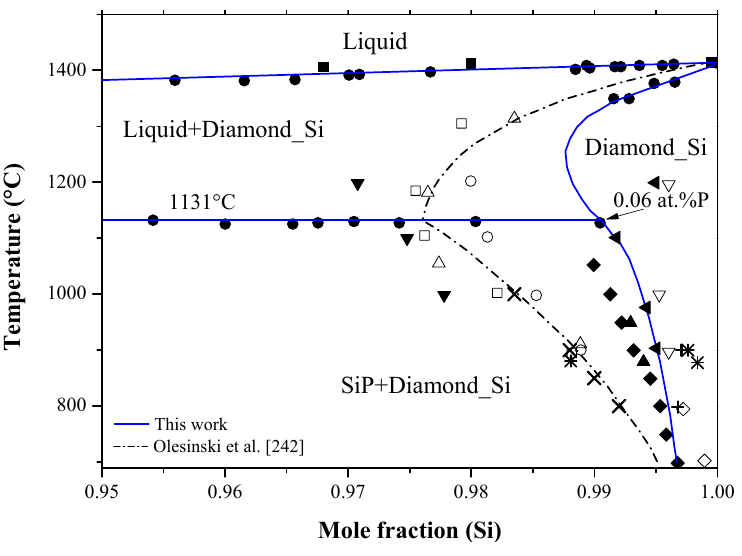
Figure 28. Assessed Si-terminal solid solution in relation to the available data; -·-·-·-: [242]; □ : [118]; ■ : [241]; Δ : [243]; : [244]; : [245]; × : [246]; +: [247]; ▲ : [248]; *: [250]; ▼ : [252]; ○ : [249]; ♦ : [253]; ◄ : [254]; ● : [255].